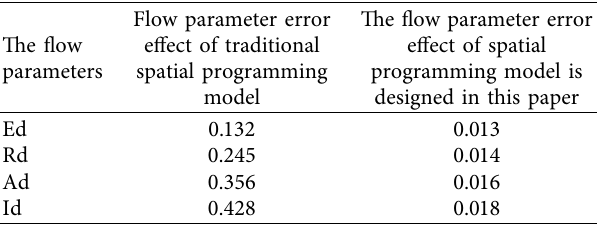
Table 4: Experimental